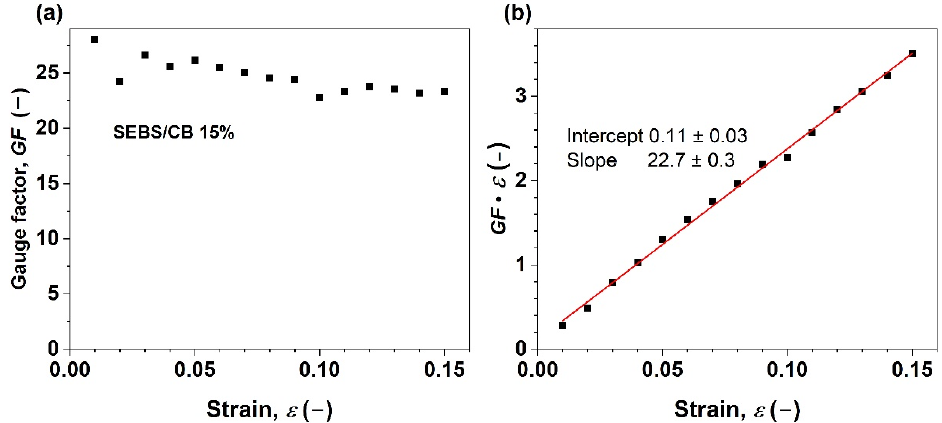
Figure 8. ( a ) Gauge factor vs. elongation of styrene-b-(ethylene-co-butylenes)-b-styrene triblock copolymer filled with 15 wt.% of carbon black (CB); ( b ) analysis of the resistivity change responsible for the piezoresistive effect. The red line represents a linear fit to the experimental data.